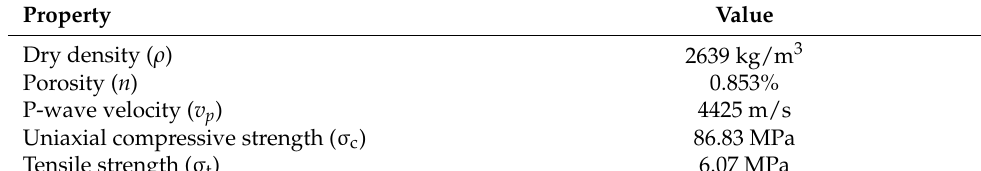
Figure 1. Photomicrograph of the granite specimen under orthogonal polarization (Q = Quartz; Kfs = Potassium feldspar; Bt = Biotite). Table 1. Physical and mechanical properties obtained from granite specimens.